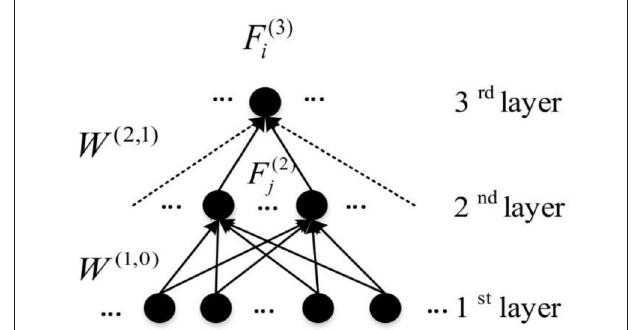
TABLE 4 | Results from the DNN-FS in different